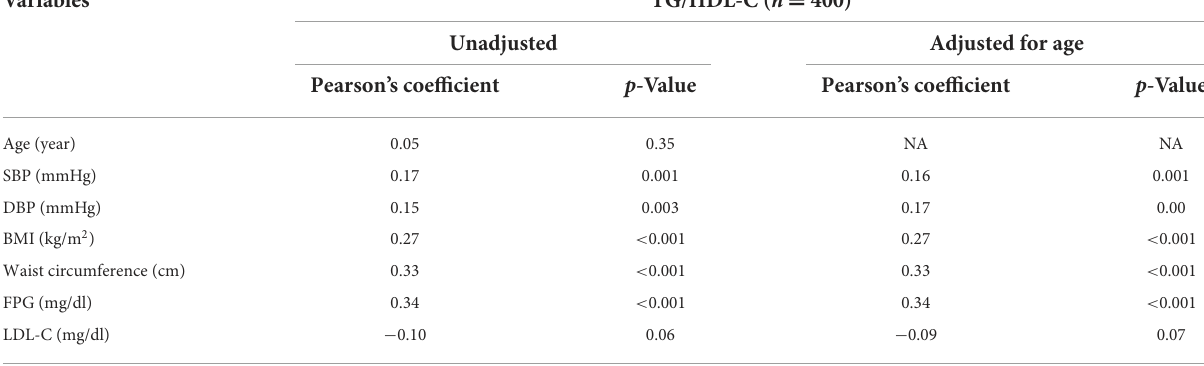
TABLE 2 Correlation between triglyceride/high-density lipoprotein-cholesterol (TG/HDL-C) and cardiovascular disease risk factors.